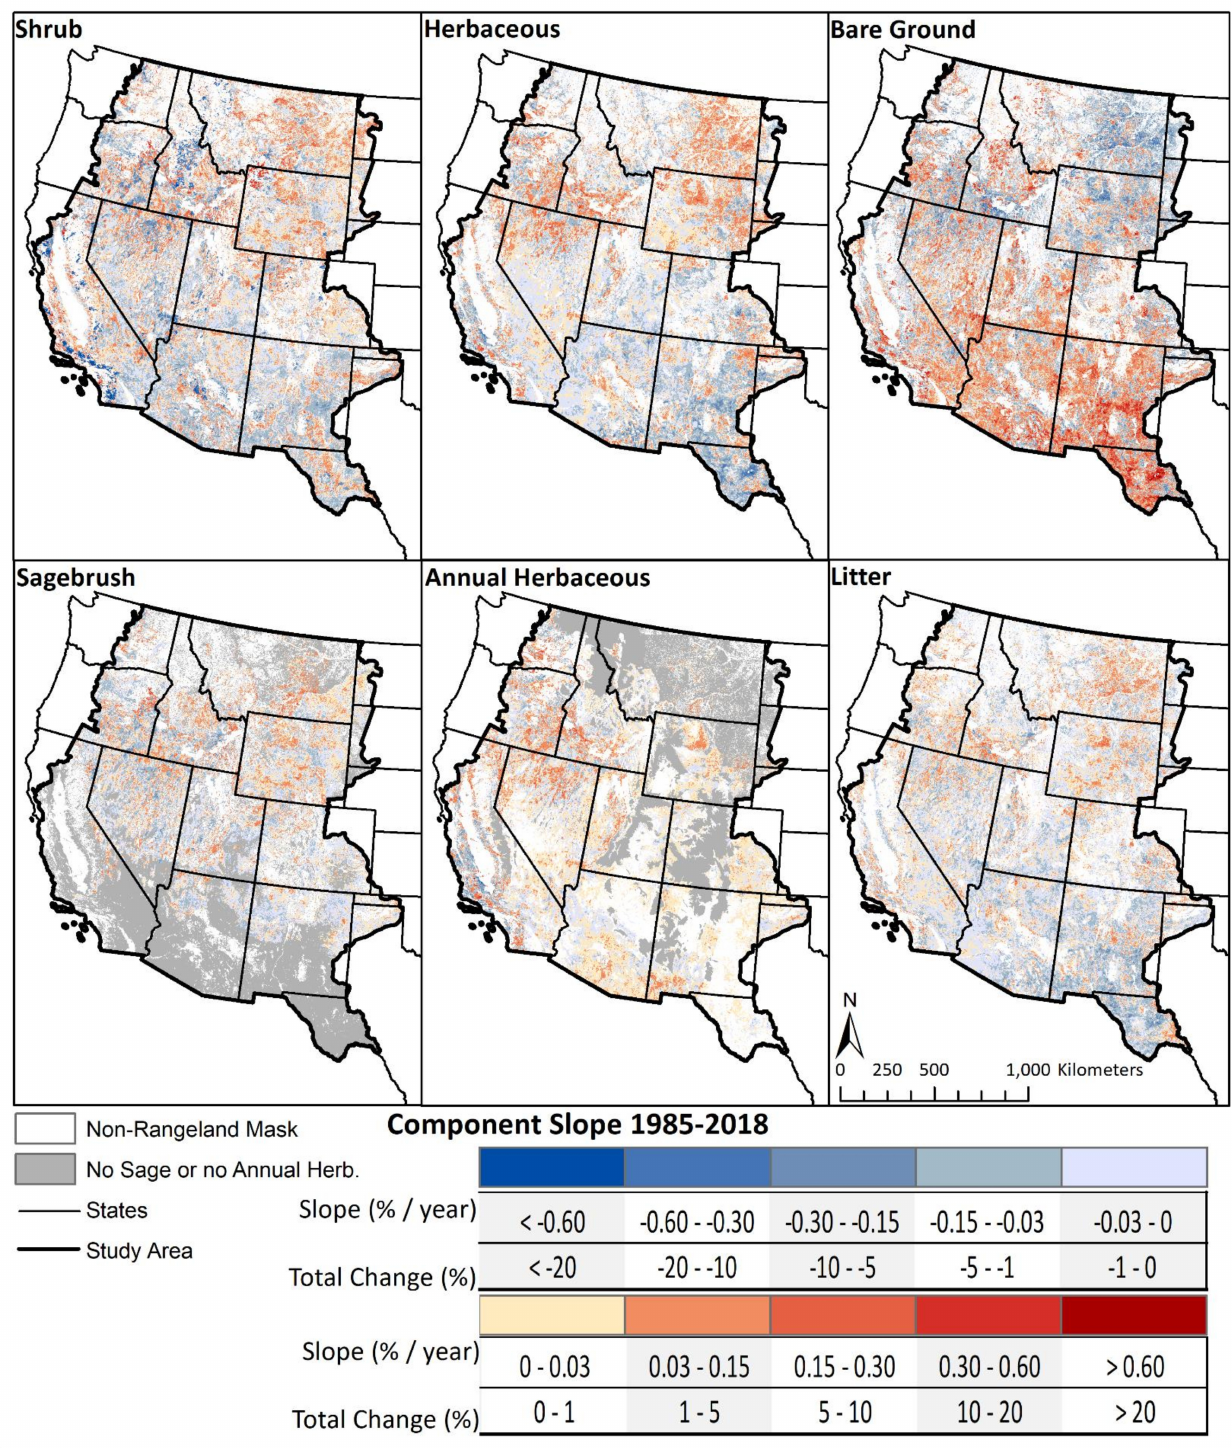
Figure 3. Temporal slope of component cover from 1985 to 2018 calculated using linear models developed for each